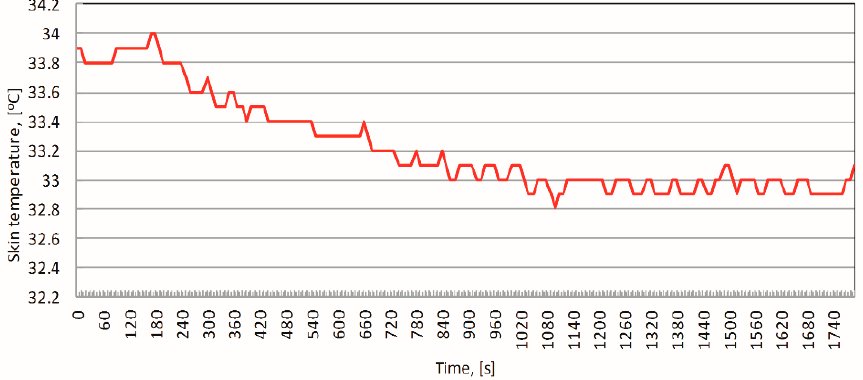
Figure 3. Face skin temperature variation.